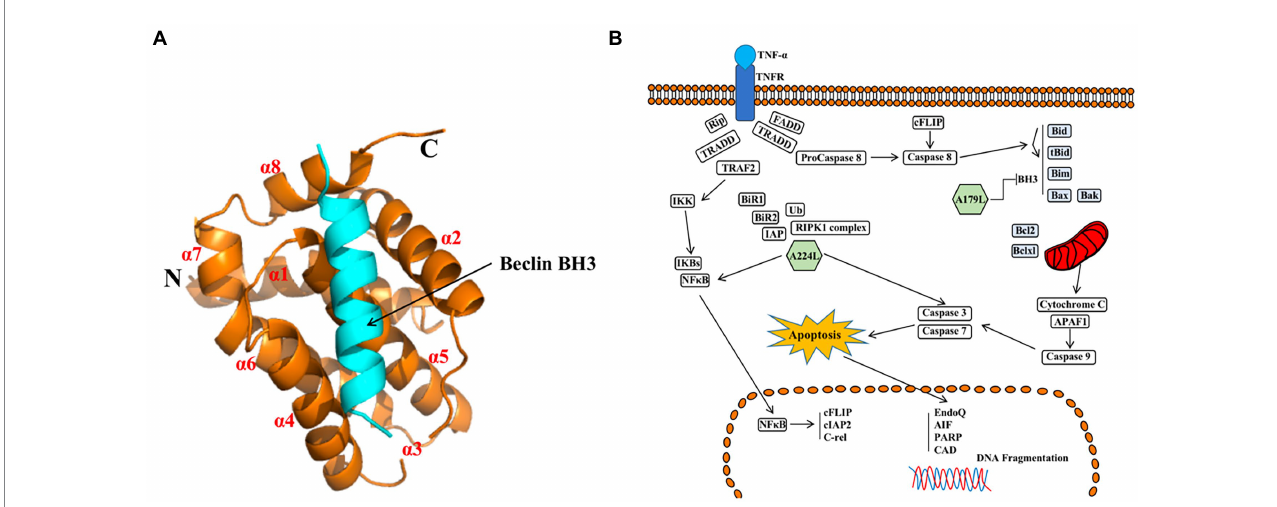
FIGURE 7 (A) Schematic diagram of ASFV A179L and BH3 complex structures (Banjara et al., 2019). (B) A224L and A179L of ASFV inhibit apoptosis of infected cells (Dixon et al., 2017). ASFV A224L and A179L are shown as green hexagons. ASFV A179L Bcl-2 family proteins bind to and inhibit several pro-apoptotic proteins with a BH3 motif. A224L IAP family proteins bind to and inhibit caspase 3 and activate the nuclear factor Kappa-light chain enhancer of activated B cell (NF- κ B) signaling, thereby increasing the expression of anti-apoptotic genes including cFLIP, cIAP2, and C-rel (Dixon et al.,